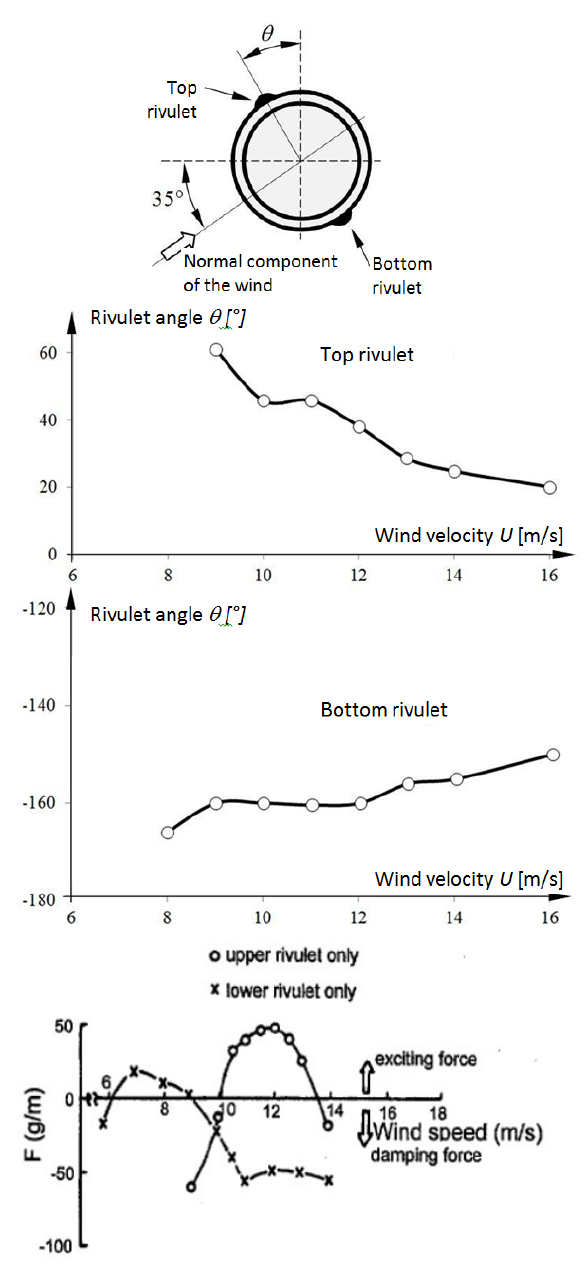
Fig. 6 . Variations of the angle of water rivulets and their aerodynamic forces with wind velocity